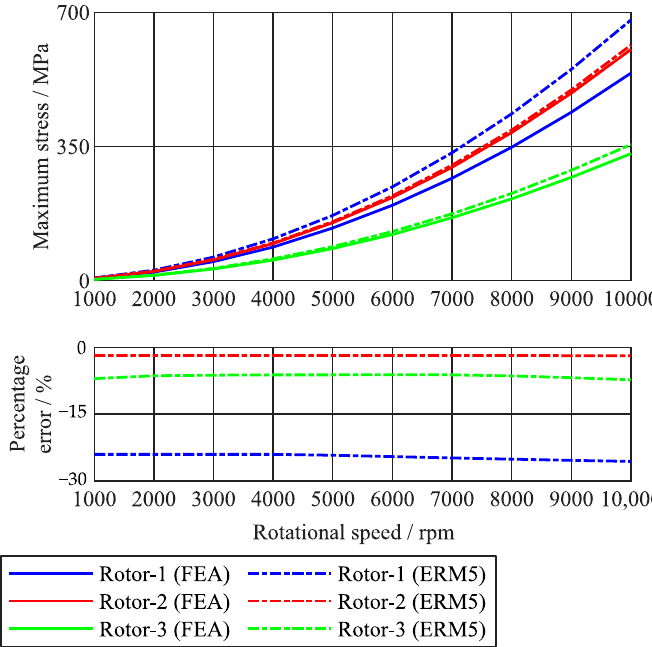
Figure 9. Stability analysis of the ERM5 method vs. rotor speed for different rotor geometries.